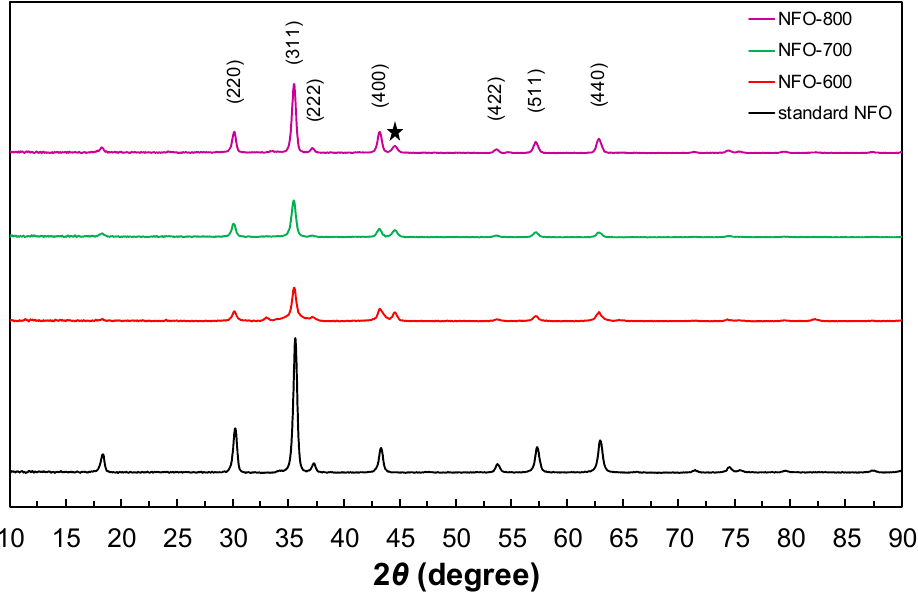
Figure 1. X-ray diffraction patterns of NiFe 2 O 4 electrode annealed at different temperatures.